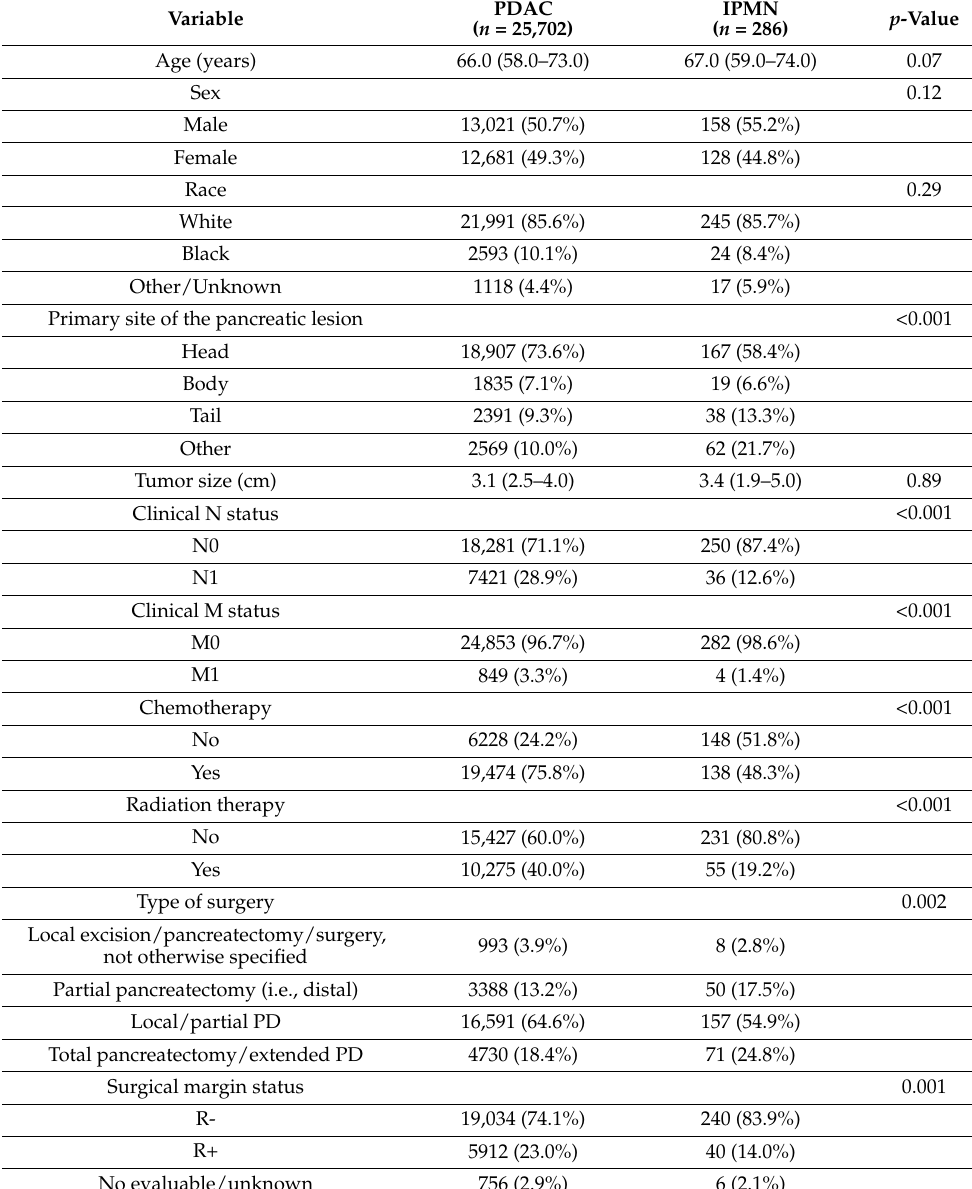
underwent distal pancreatectomy or total pancreatectomy/extended PD, while a higher proportion underwent a local/partial PD ( p = 0.002) compared with IPMN patients. A with IPMN patients. Detailed characteristics of the surgical cohort are presented in Table 2. Table 2. Demographics by tumor type in the surgical